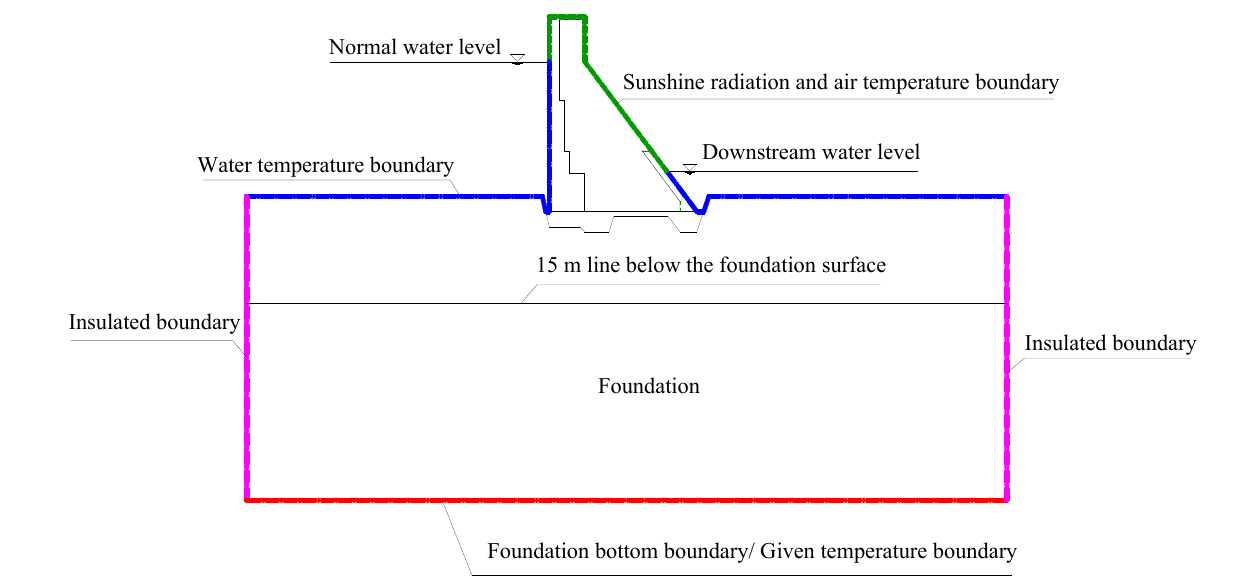
Figure 10. Boundary conditions for the temperature field calculation.